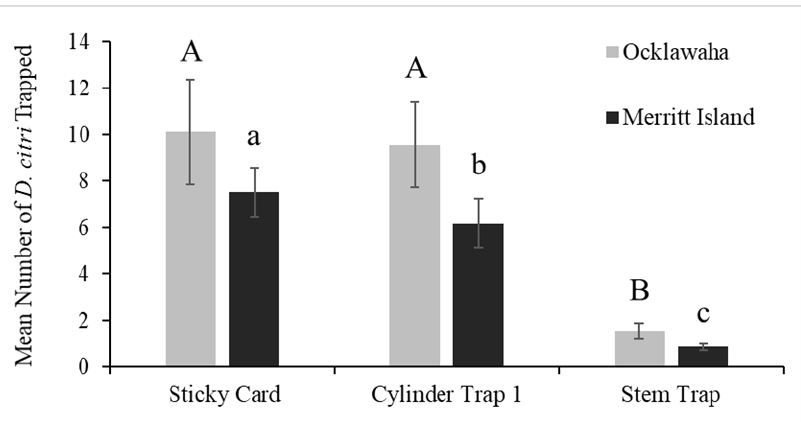
Figure 4. Comparison of ACP capture rates per trap-type in Florida fields using the Poisson test. The three trap-types were deployed in eight blocks per location between 1 May 2018, to 26 June 2018. The number of traps deployed in Merritt Island was 48 and in Ocklawaha was 128. The calculated mean number of psyllids per trap in Ocklawaha were 10.1 for sticky cards, 9.6 for cylinder trap 1 and 1.6 for stem traps. In Merritt Island, the calculated mean numbers were 7.5 for sticky cards, 6.2 for cylinder trap 1 and 0.9 for stem traps. Standard error bars are shown. The use of different letters indicates significant differences in the ACP capture rate within each site (represented by A, B in Ocklawaha and a, b, c in Merritt Island).